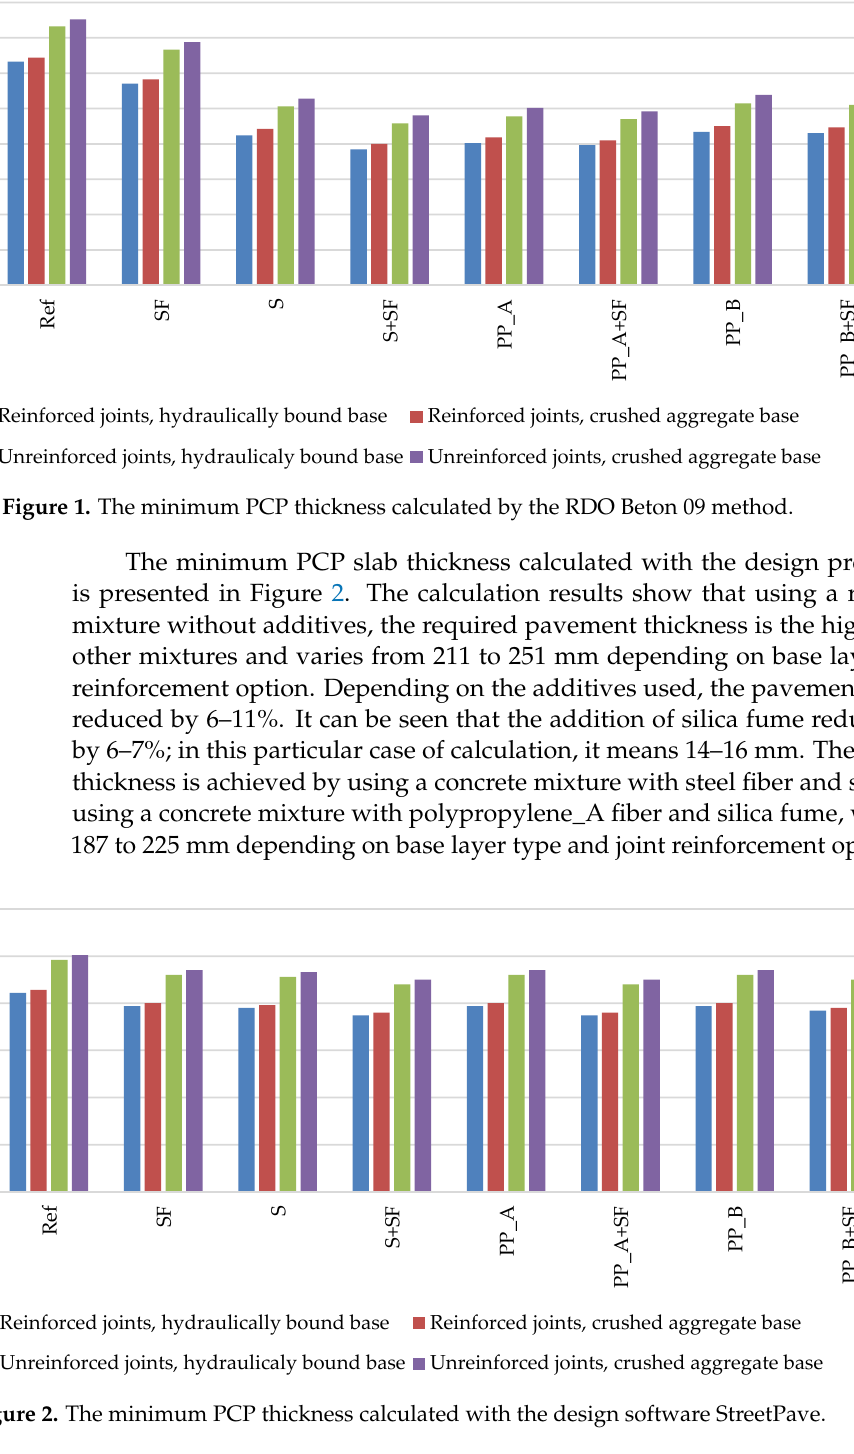
Figure 2. The minimum PCP thickness calculated with the design software StreetPave.